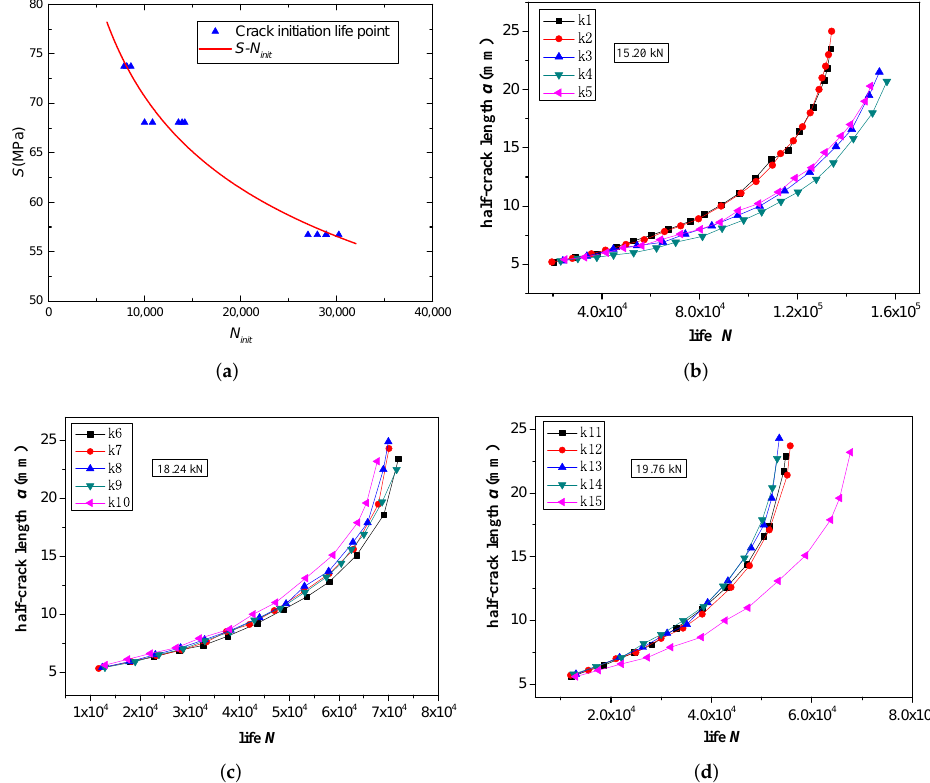
Figure 2. ( a ) Crack initiation life and S - N init curve. ( b ) Crack growth curve of 15.20 kN. ( c ) Crack growth curve of 18.24 kN. ( d ) Crack growth curve of 19.76